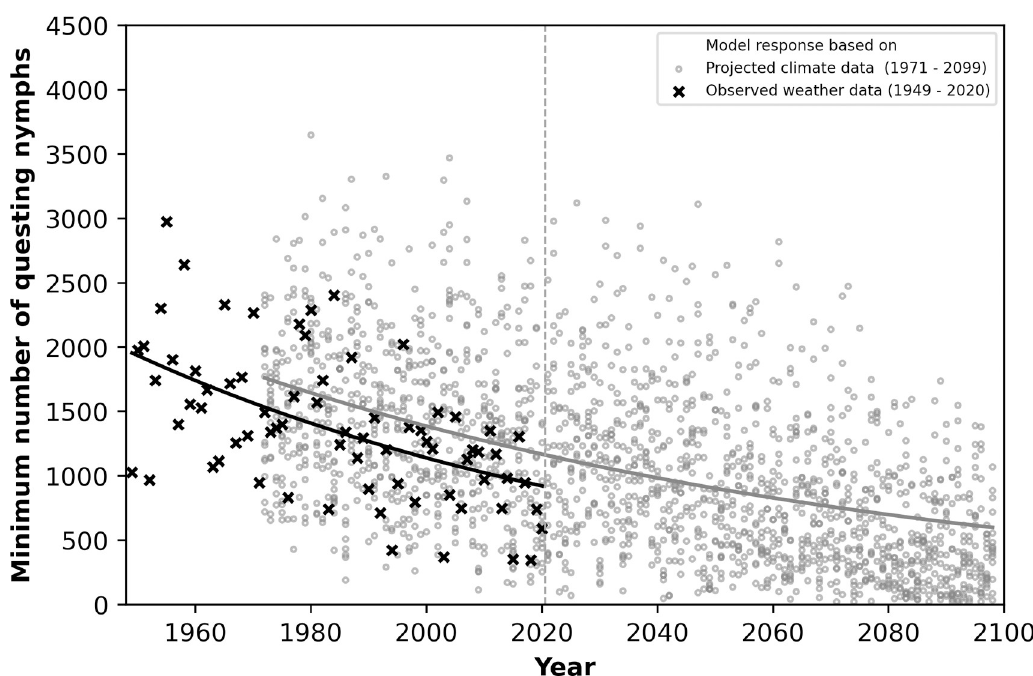
Fig 7. Minimum number of questing nymphs on the simulation landscape in the summer month (June–August) for the period 1949–2099. Simulations were conducted with observed weather data between 1949 and 2020 (black crosses) and with weather data from 15 climate models between 1971 and 2099 (grey circles). The dashed vertical grey line between 2020 and 2021 indicates the border between past and future years. https://doi.org/10.1371/journal.pone.0267196.g007 found high nymphal densities in the federal states of Saarland, Rhineland-Palatinate, and in the west of North Rhine-Westphalia. In the short-term scenario (2012–2041), this trend con- tinued towards the north-east (Hesse, Saxony-Anhalt), north (North Rhine-Westphalia, Lower Saxony) and east (Bavaria). In Saarland and Rhineland-Palatinate, tick hotspots with nymphal densities in the range of 1,000 nymphs / 100 m 2 are already evident. In the mid-term scenario (2050–2079), high tick densities were found nationwide. In large parts of most federal states, densities of > 750 nymphs / 100 m 2 were simulated. Exceptions with relatively low nymphal densities (200 nymphs / 100 m 2 ) were found in urban areas of Berlin, Hamburg, Bremen, and parts of the Ruhr area and also in the north of Schleswig-Holstein, the south-west of Baden- Wu¨rttemberg and in south-eastern Germany (Bavaria, Saxony). The long-term scenario (2070–2099) is qualitatively comparable to the mid-term scenario, but the nymphal densities